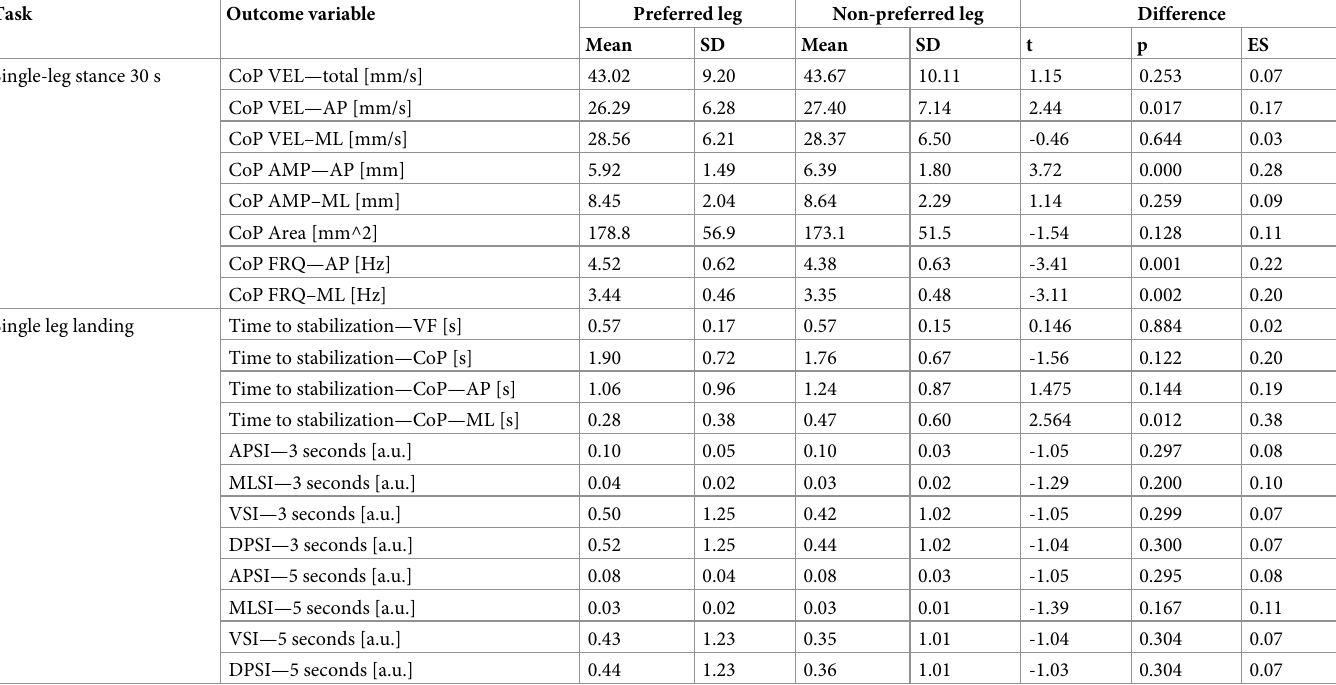
Table 1. Effect of leg preference (for kicking a ball) on body sway and landing variables. Task Outcome